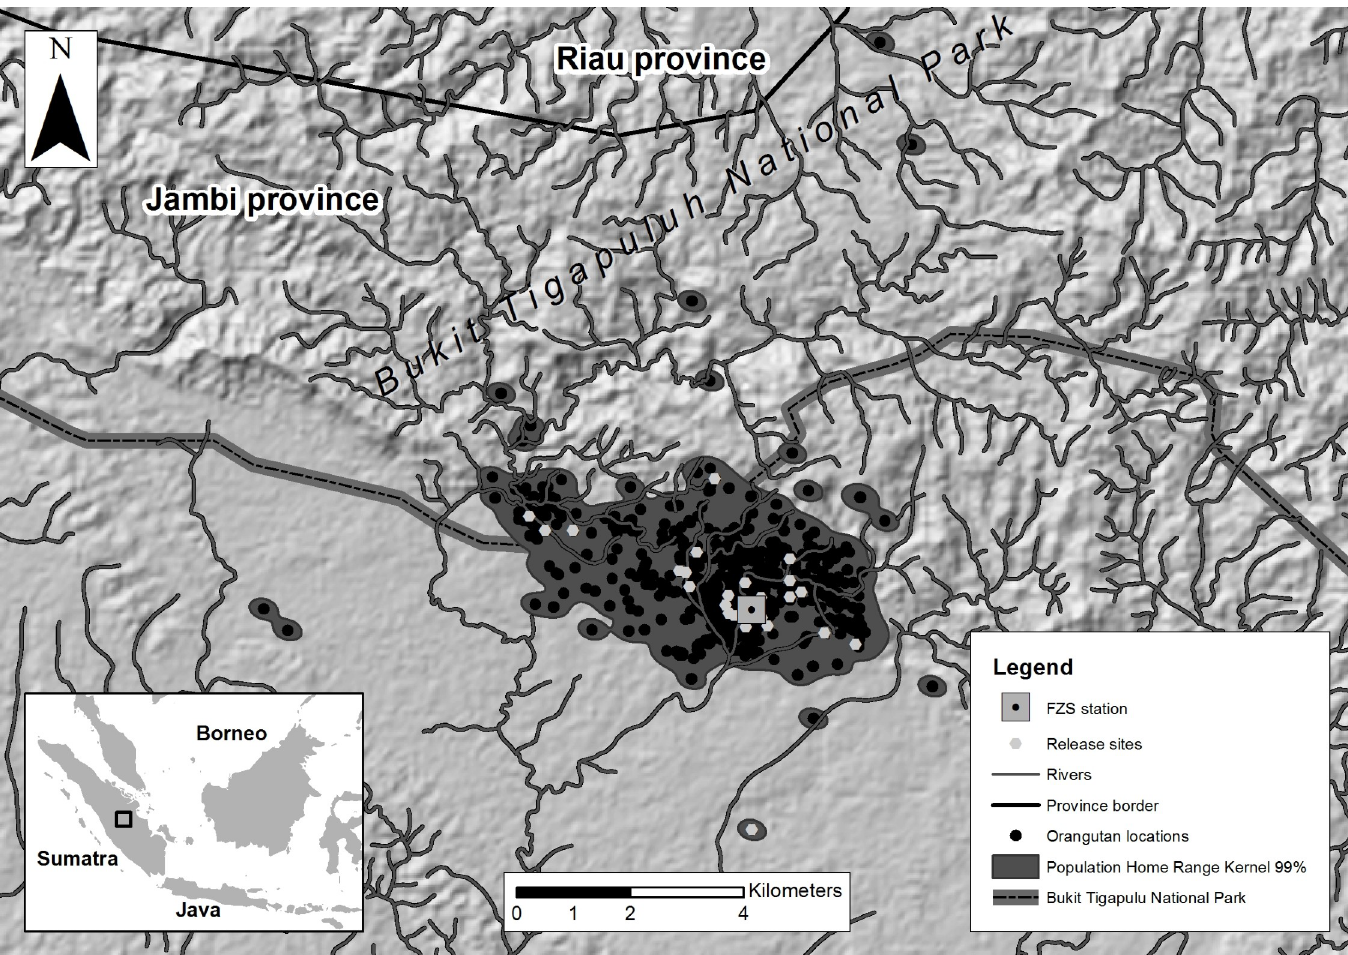
Fig 1. Orangutan study area located at the edge of the Bukit Tigapuluh National Park. Black dots around the Frankfurt Zoological Society (FZS) station (-1˚16’N, 102˚ 56’E) represent orangutan relocations collected using Very High Frequency radio tracking from 2011 to 2013 (n = 32 orangutans; n = 1,020 VHF relocations). Relocations were used to estimate the population-level home range (Kernel method, 99% isopleth). Grey dots represent locations where orangutans have been released. Individual orangutan maps are presented in the supporting information (S1–S8 Figs).